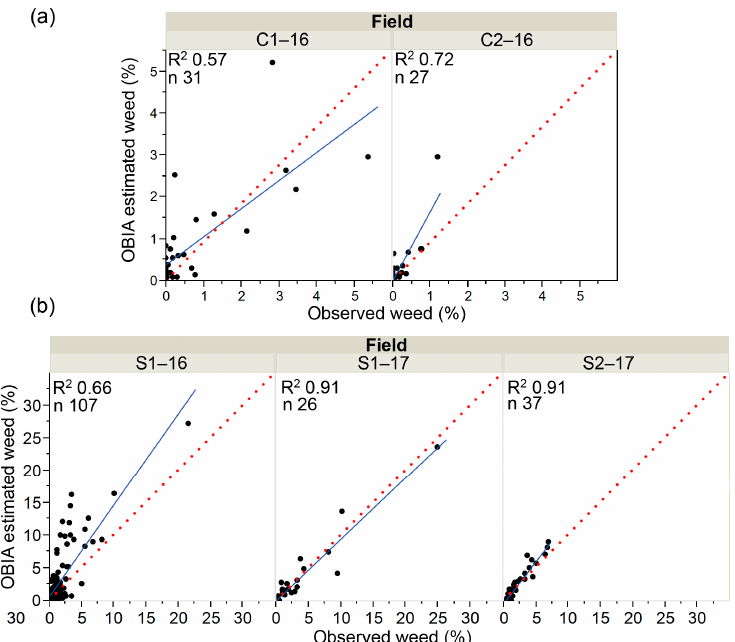
Figure 10. Graphics comparing observed and OBIA-estimated weed coverage at the 30 m flight altitude: ( a ) cotton fields; ( b ) sunflower fields. Correlation coefficients ( R 2 ) derived from the calculated regression fit are included for every scenario ( p < 0.0001). The solid and dotted lines represent the fitted linear function and the 1:1 line, respectively.